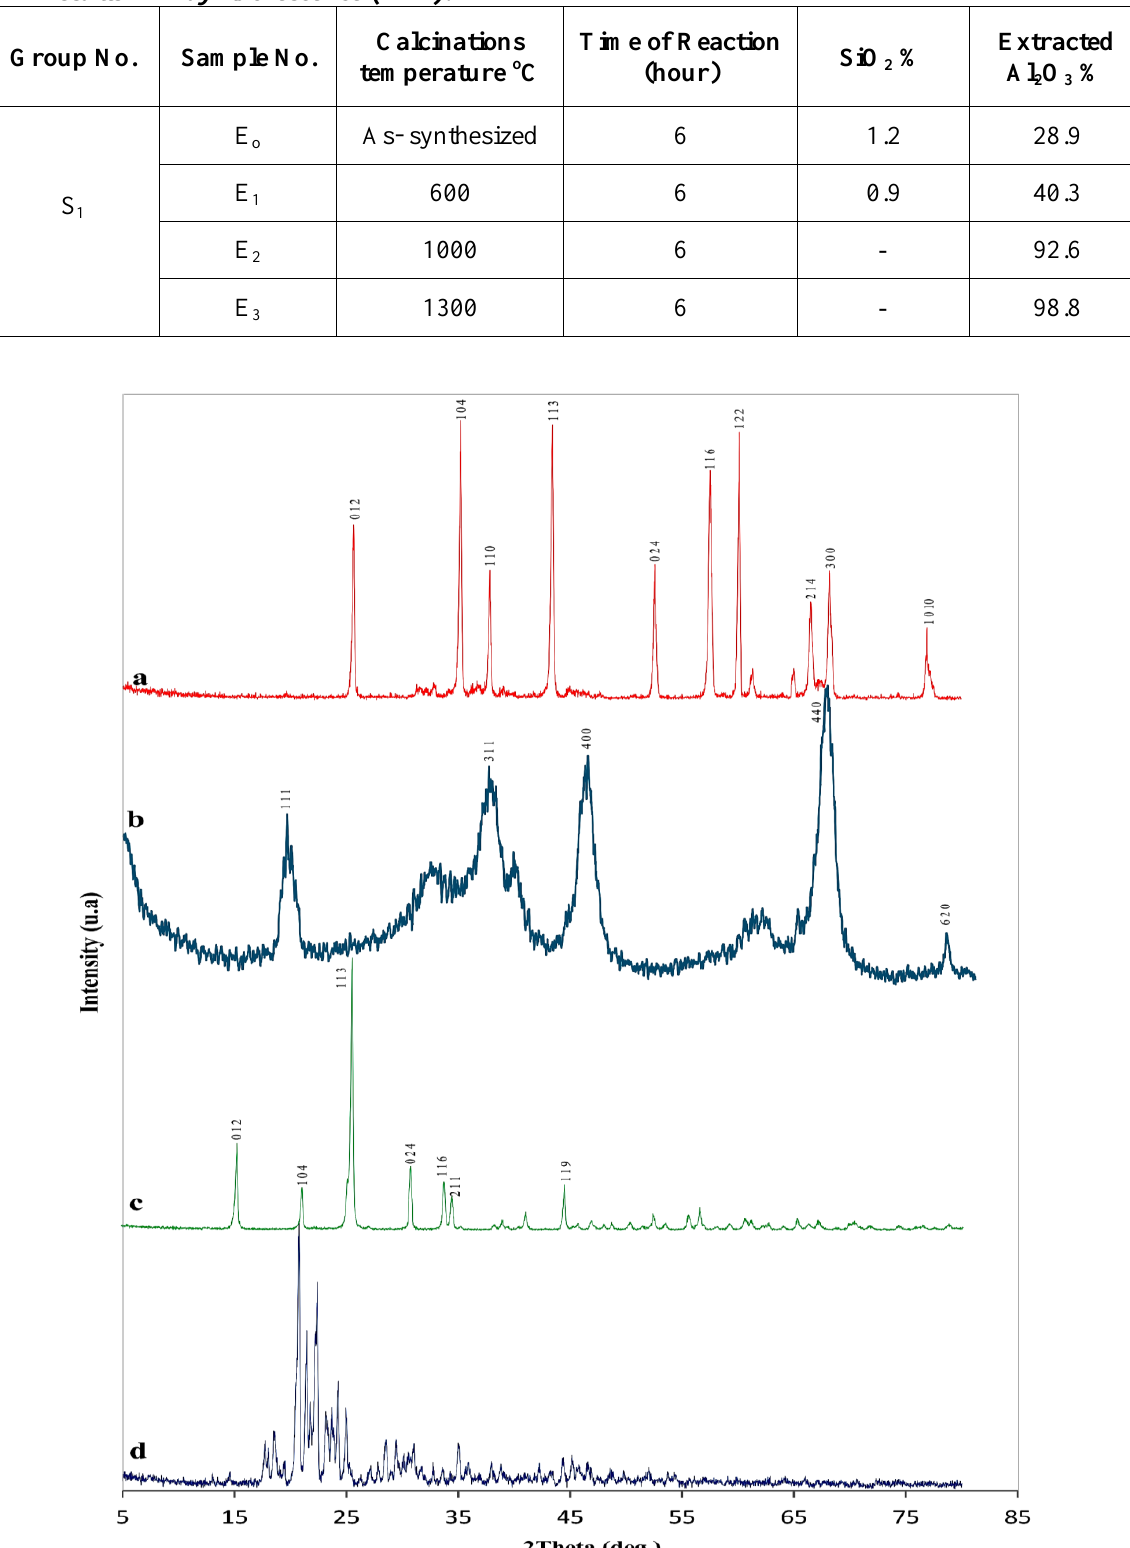
, samples E . a. Alpha Alumina at 1300 o C. b. Gamma 1 n